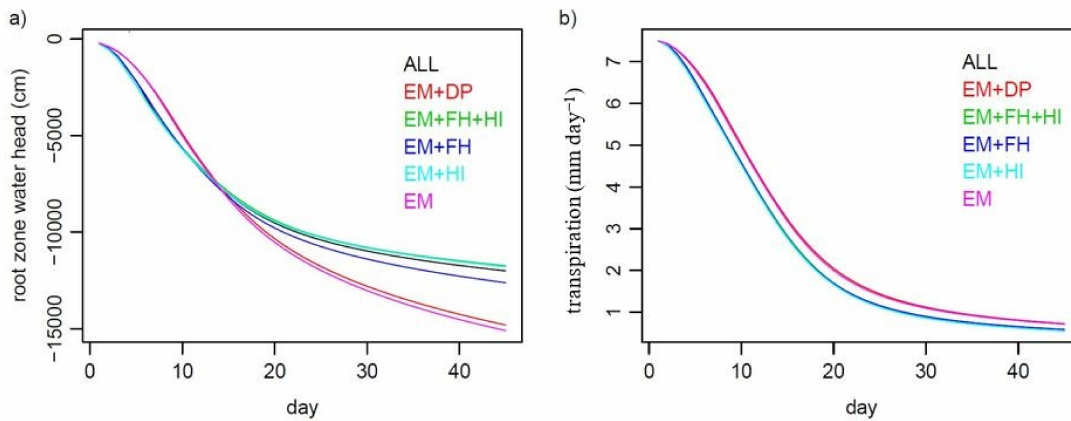
Figure 4. Development of water head in the root zone ( a ) and transpiration rate ( b ) during drying period. Daily values, diurnal variations